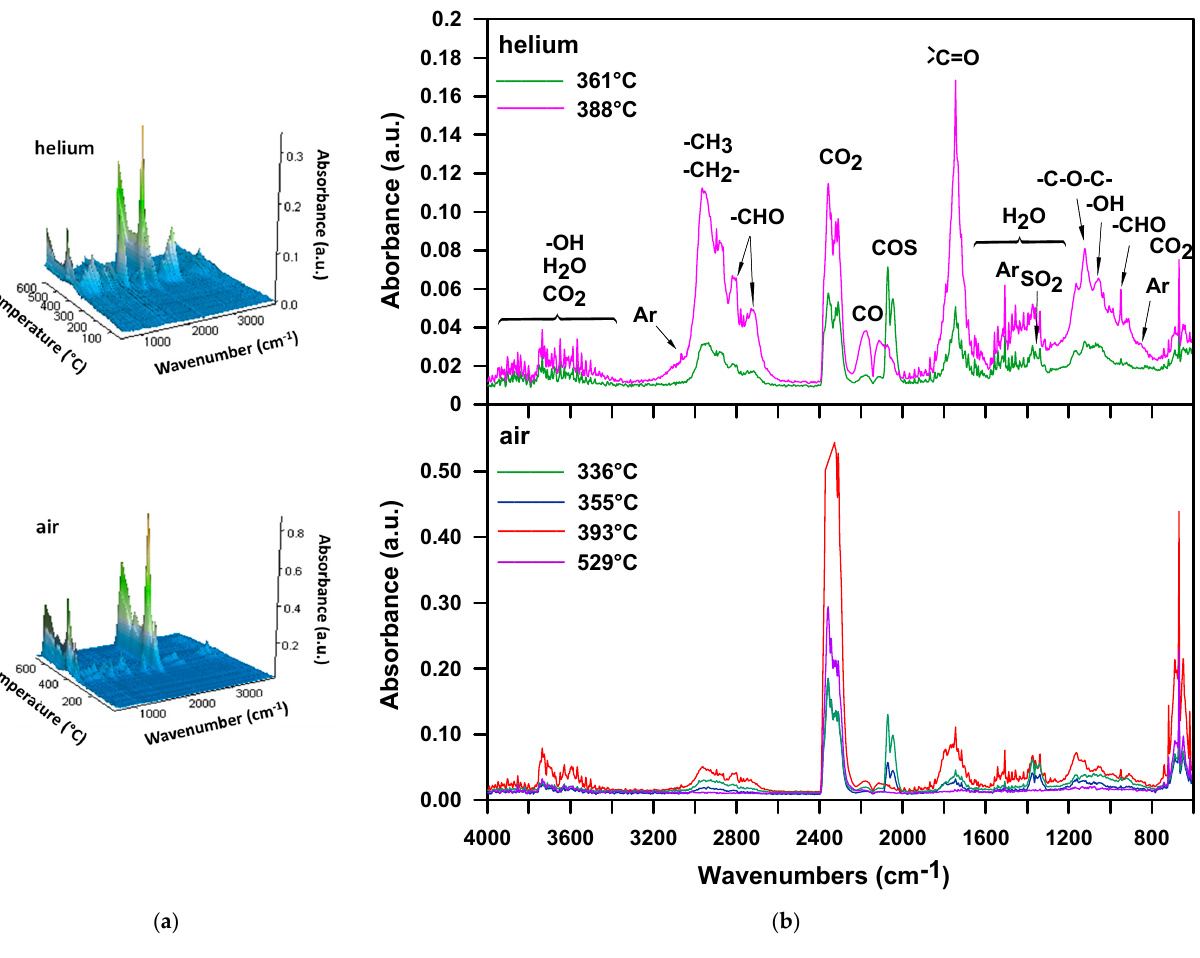
Figure 11. FTIR spectra of volatile products evolved during thermal decomposition of M-50: ( a ) 3D and ( b ) extracted at the maxima of decomposition.